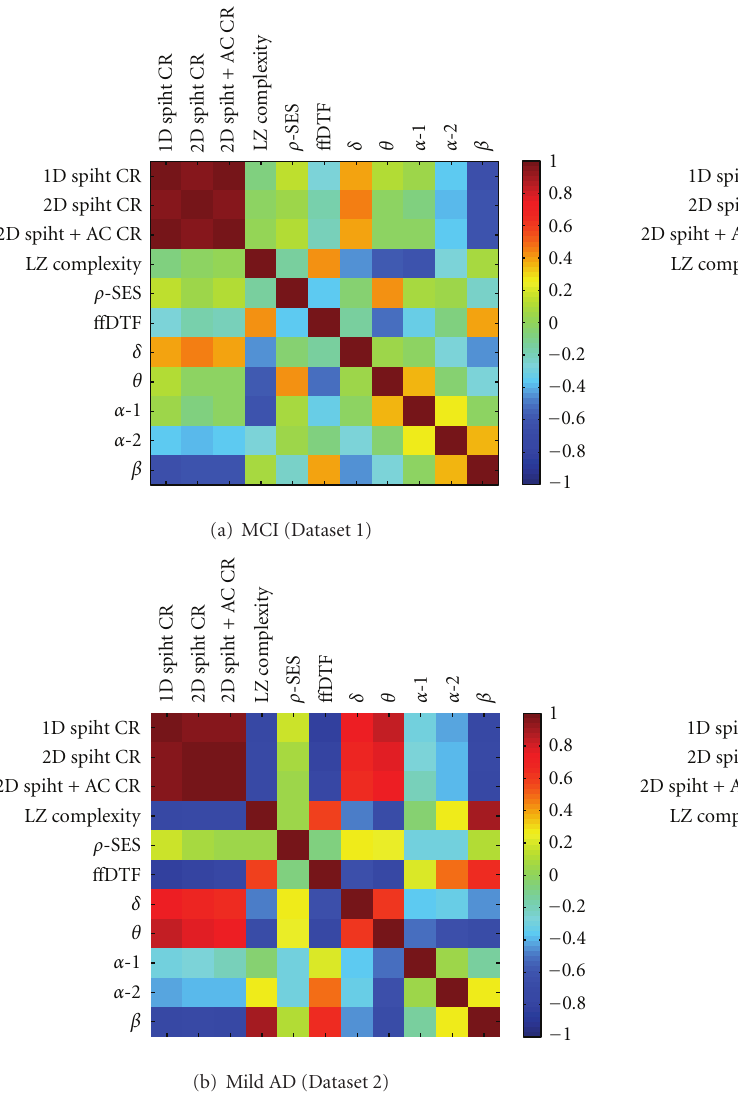
Figure 7: Pearson correlation test between the lossless compression ratios, LZ complexity, relative power in di ff erent bands, Granger causality ( ff DTF), and stochastic event synchrony ( ρ ). The (uncor- rected) P values are shown on a logarithmic